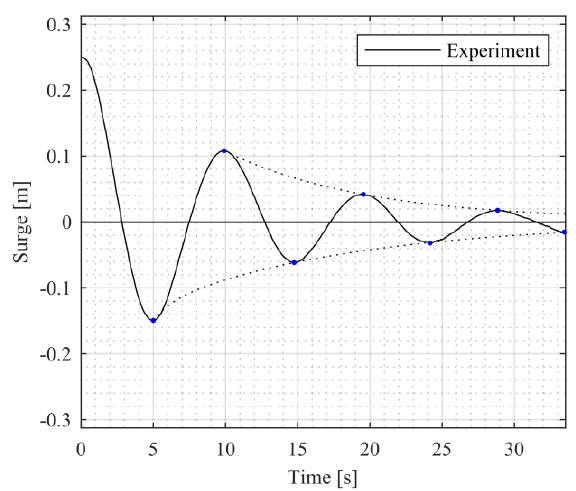
Figure 14. Time series of experimental surge decay test in model scale.